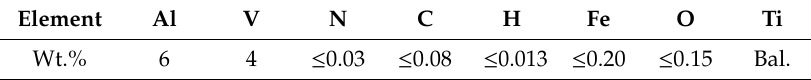
Table 1. Chemical composition of as-received Ti-6Al-4V